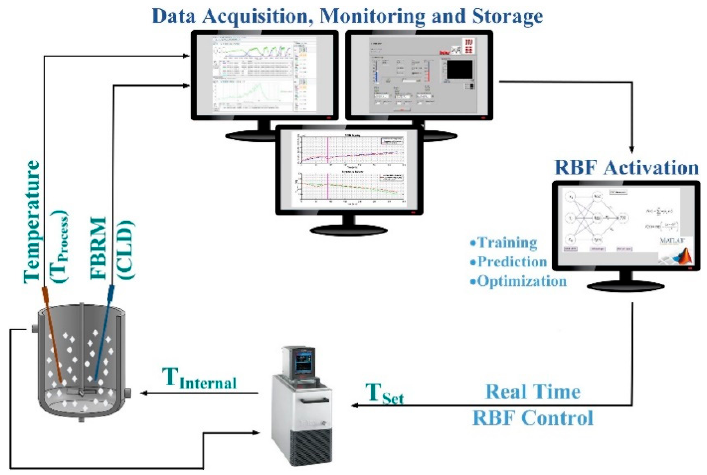
Figure 1. Robust control of crystallization process based on radial basis function (RBF) neural network. (Figure adapted from Reference [32], Copyright 2020, Elsevier).